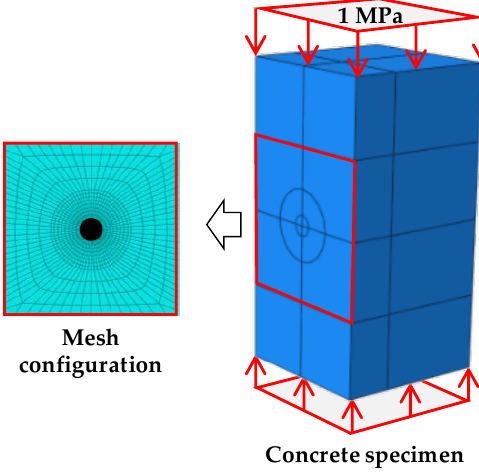
Figure 4. FE model of the concrete specimen.